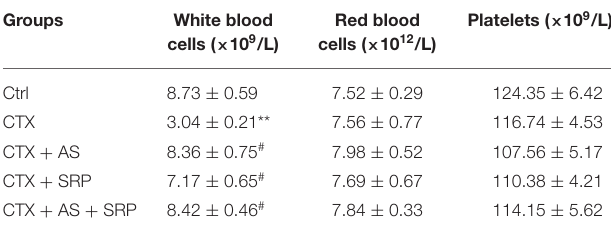
TABLE 1 | Effect of Astragaloside IV and saponins of rhizoma polygonati on general blood indexes in mice.